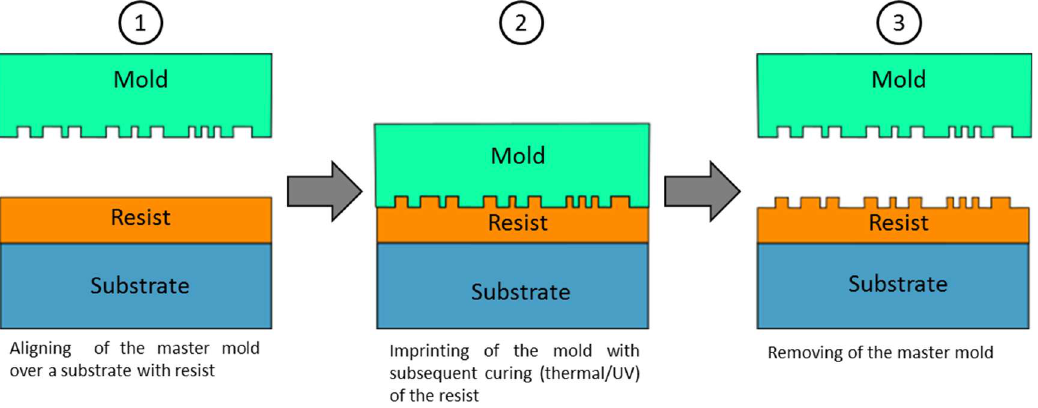
Figure 10. Nanoimprint lithography (NIL) process chain.